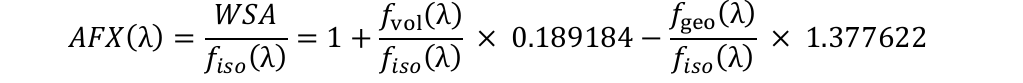
, f , f ) iso vol geo